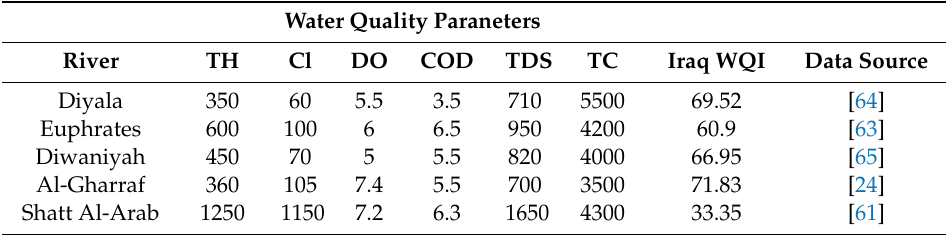
Table 5. The application of the proposed (Iraq WQI) index for sites on some Iraqi